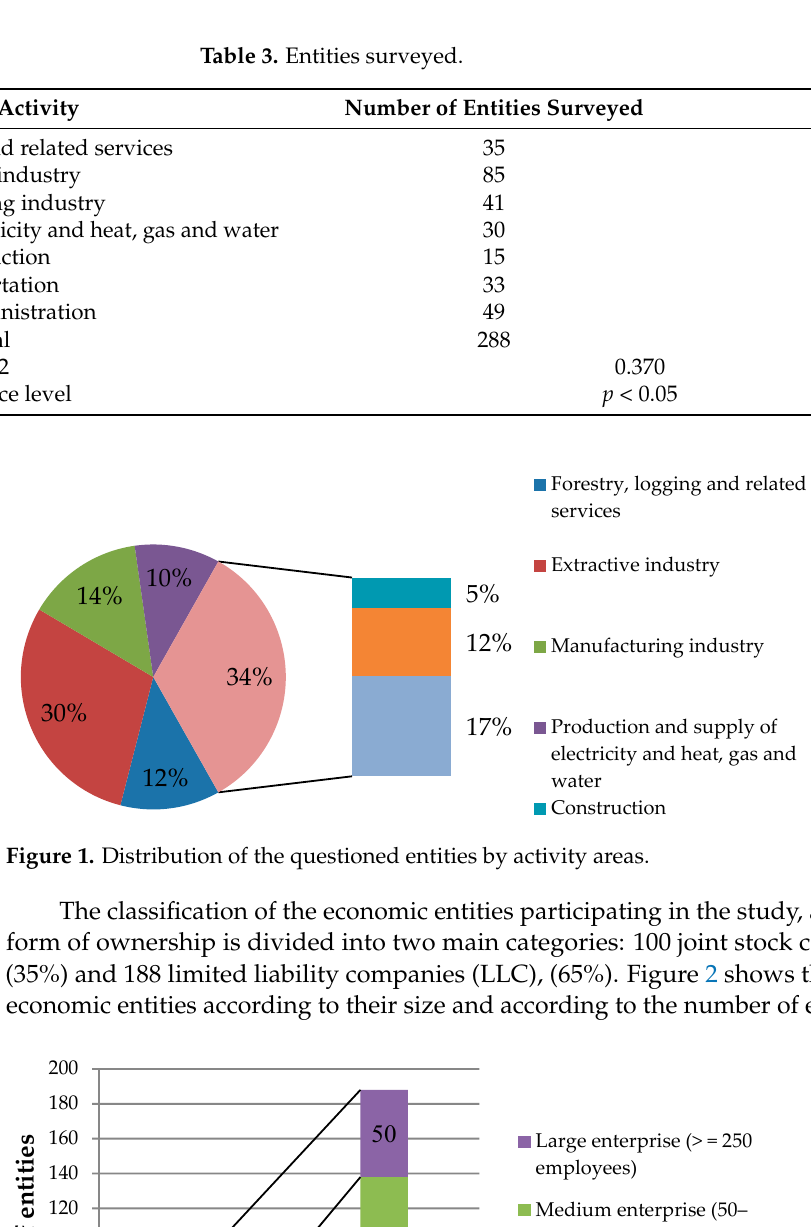
Figure 2. Classification of economic entities.